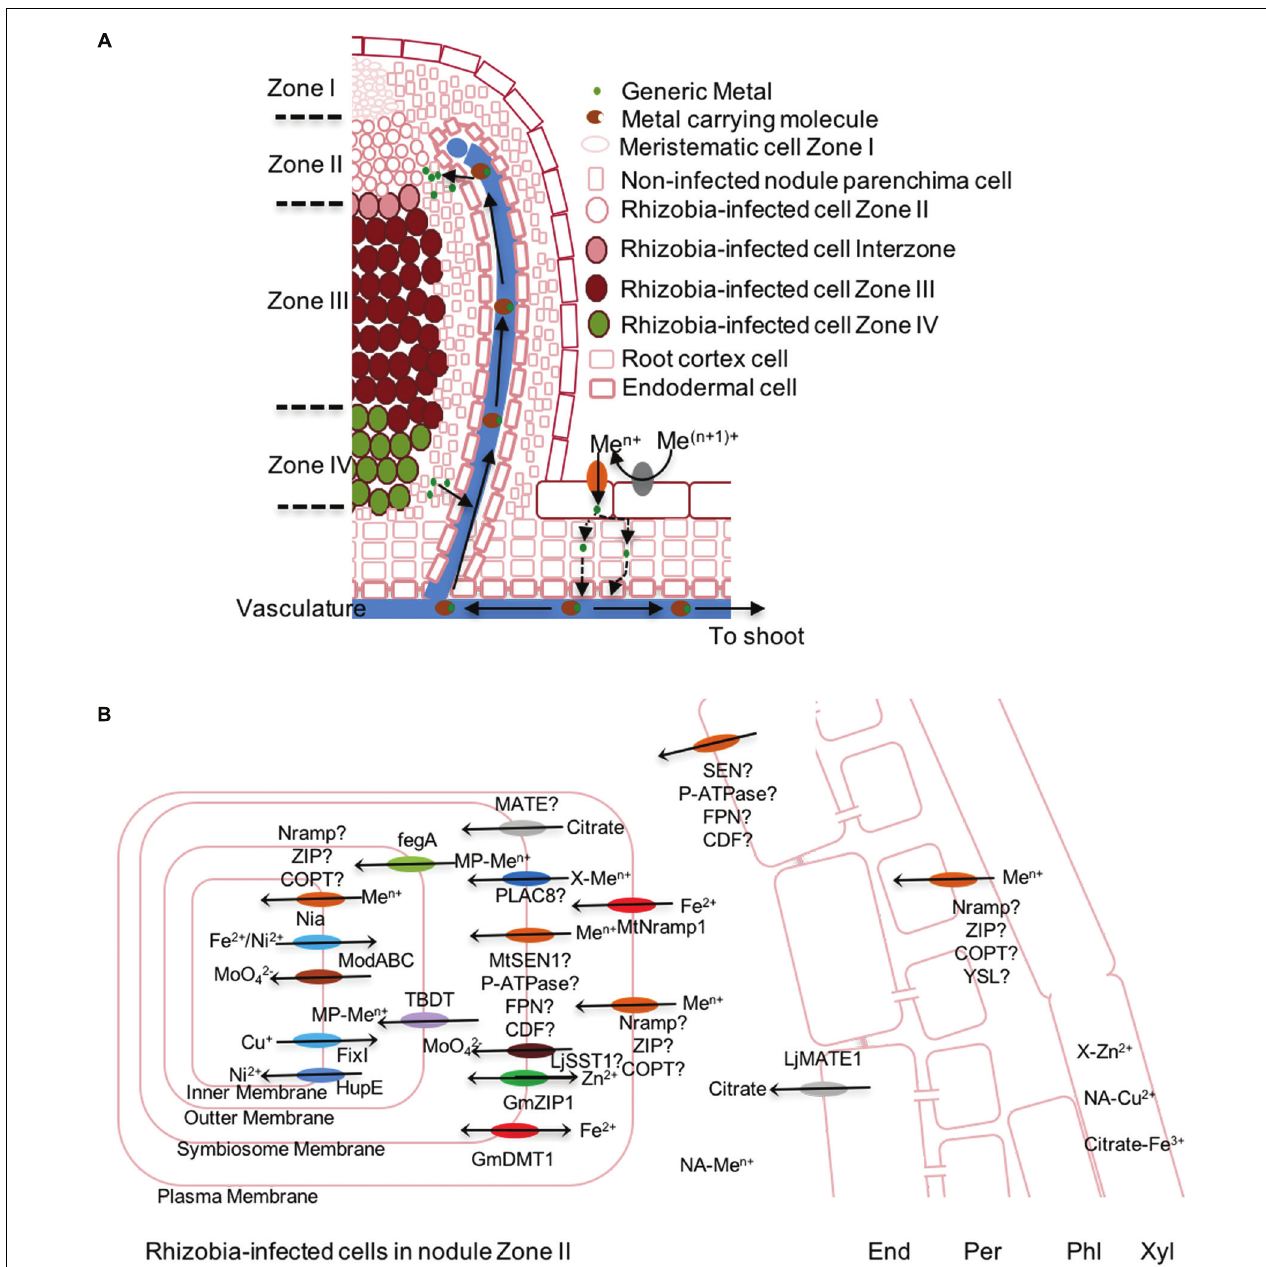
FIGURE 4 | Metal transport in indeterminate nodules. (A) General overview of metal delivery and recovery to legume nodules. (B) Detail of transport process to deliver metals to symbiosomes in the nodule Zone II. Mt is used as a prefix to indicate M. truncatula proteins, Gm for G. max , and Lj for Lotus japonicus . X or MP are used to indicate an unkown metal chelator or a general metallophore, respectively. End stands for Endodermis, Per for Pericycle, Xyl for Xylem, Phl for Phloem, and Me n + for a general